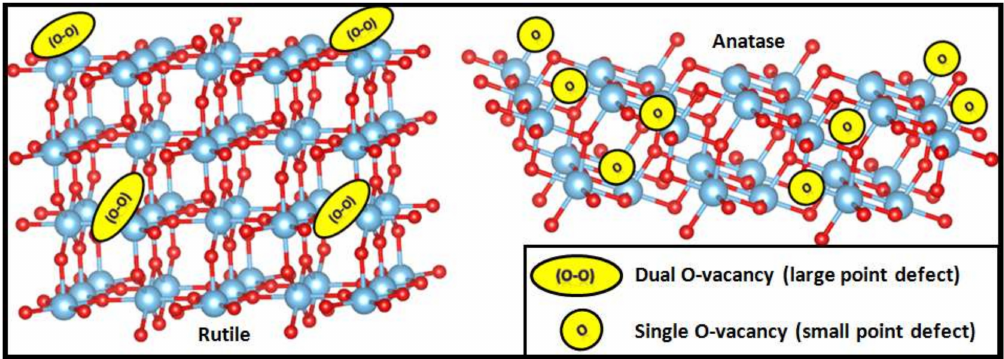
Figure 6. O-vacancy dispersion in the bulk and on the surface of anatase and rutile